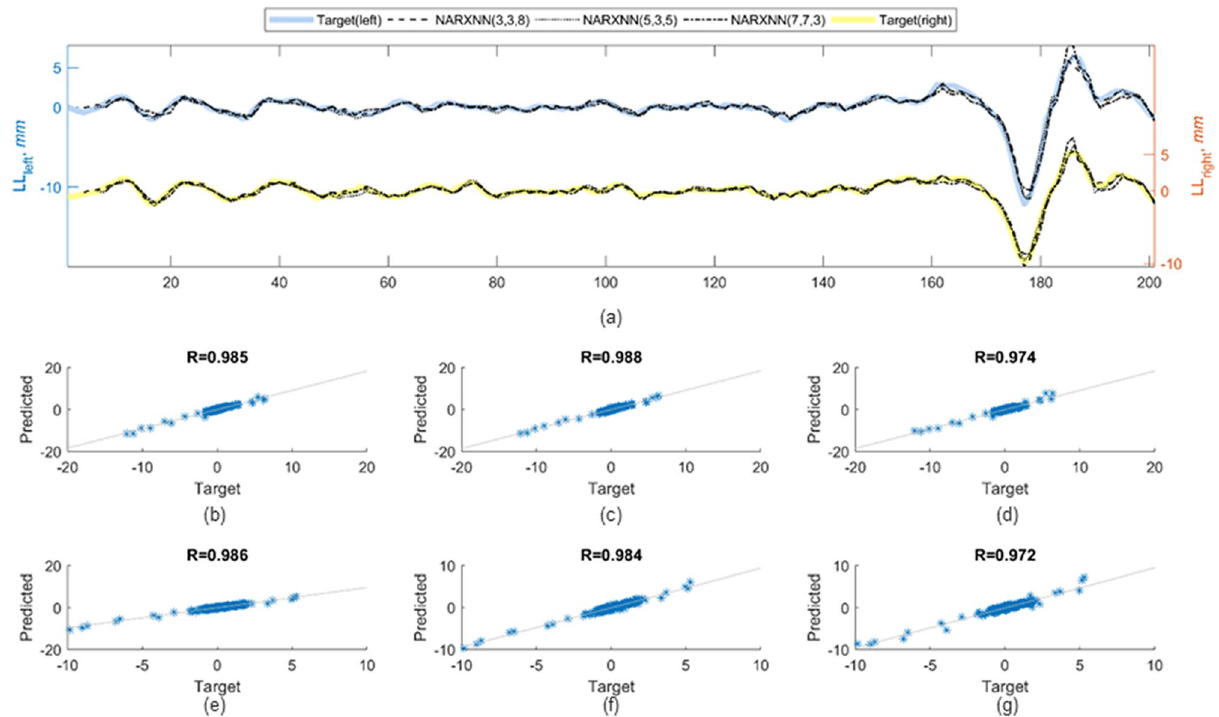
Figure 9. Predicted and target values of longitudinal track level of S3 for left and right rail are superimposed in the plot ( a ). Overall prediction accuracy of different networks can be observed from the scatter plot ( b – d ) and ( e – g ) for left and right rail, respectively.